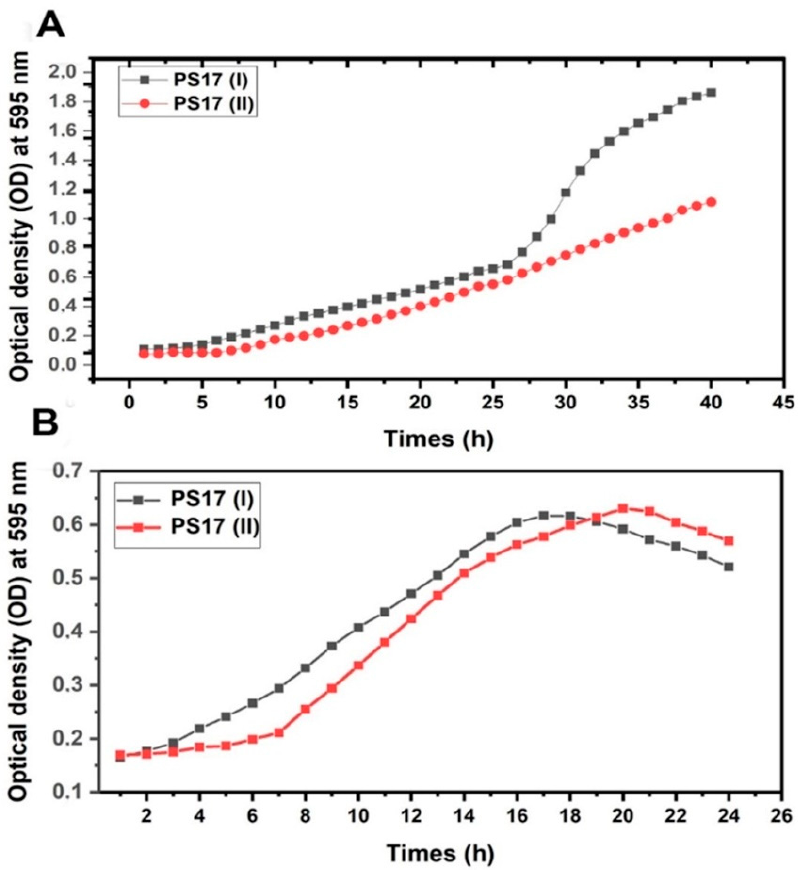
Figure 4. Graph showing growth curve of B. mojavensis PS17 morphotypes I and II in M9 medium ( A ) and LB medium ( B ).